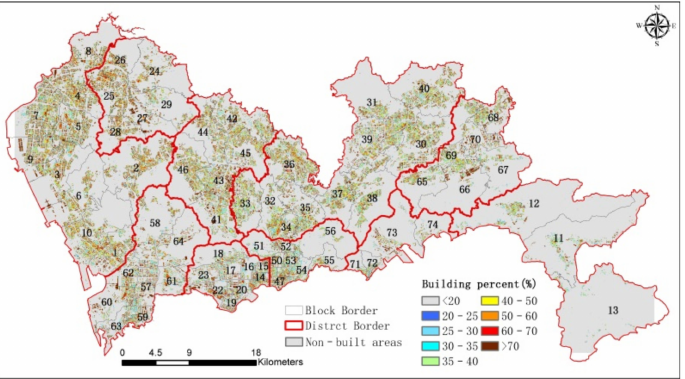
Figure 11. Building density distribution in